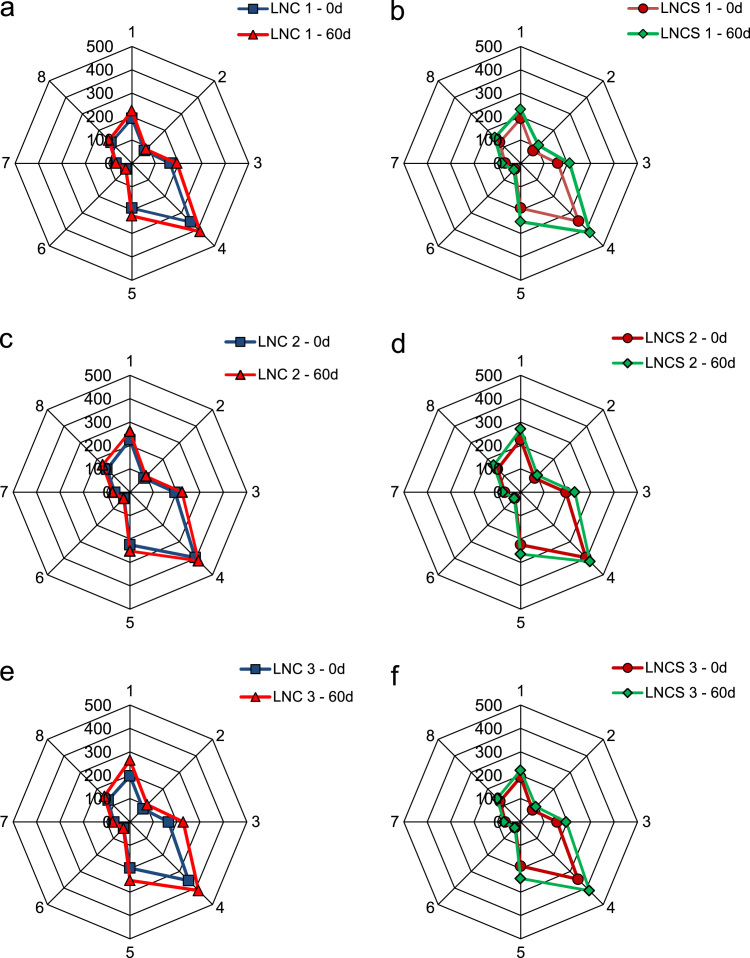
Radar charts plot for nanocapsules formulations, non-sterile (LNC) and sterile (LNCS), storage at 5 °C (60 days). [axes: 1 - volume-weighted mean diameter by volume of particles, d[3,4]v; 2 - diameter by volume at percentile 10 under the distribution curve, d(0.1)v; 3 - diameter by volume at percentile 50 under the distribution curve, d(0.5)v; 4 - diameter by volume at percentile 90 under the distribution curve, d(0.9)v; 5 - volume-weighted mean diameter by number of particles, d[3,4]n; 6 - diameter by number at percentile 10 under the distribution curve, d(0.1)n; 7 - diameter by number at percentile 50 under the distribution curve, d(0.5)n; 8 - diameter by number at percentile 90 under the distribution curve, d(0.9)n].